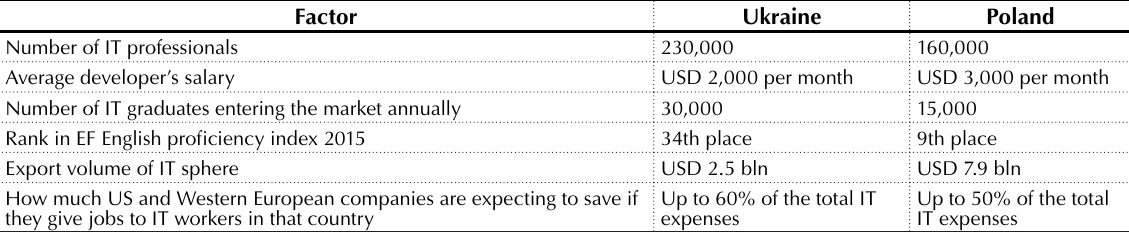
Source: Top IT Outsourcing Destinations: Ukraine vs. Poland